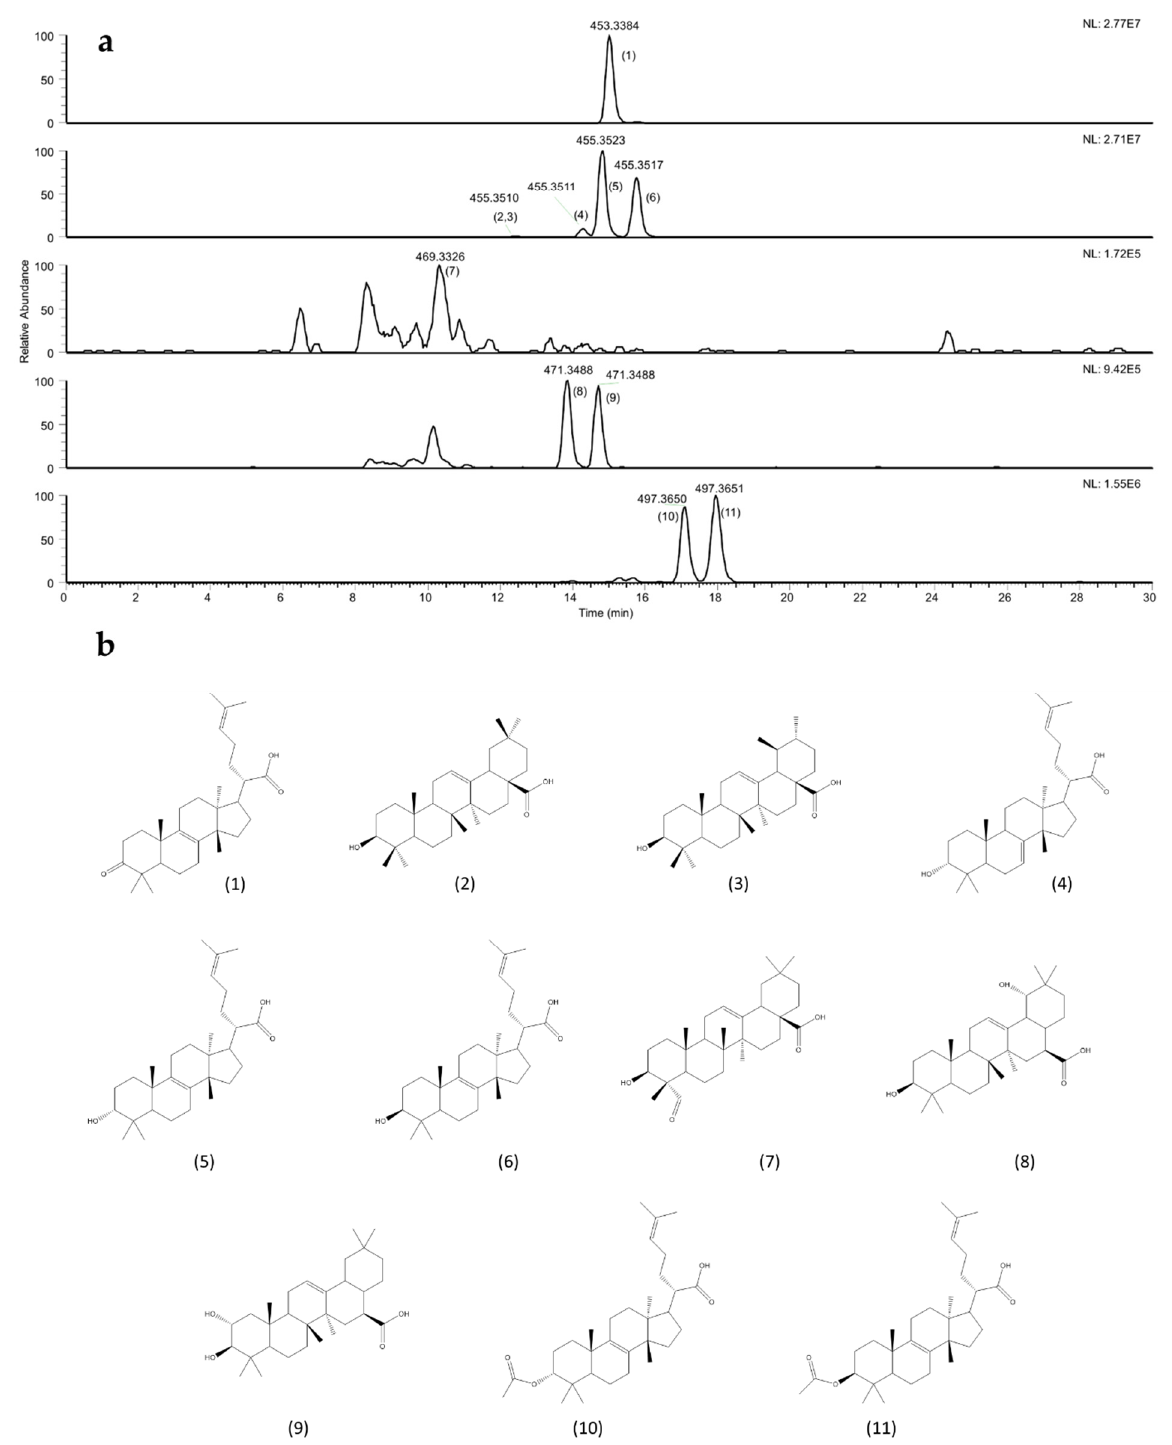
Figure 2. ( a ) Chromatographic separation of acidic triterpenes in ATCE sample; for each peak, m/z accurate value is reported. ( b ) Structure of proposed triterpenes: (1) 3-oxo -tirucalla-8,24-dien-21-oic acid, (2) oleanolic acid (3) ursolic acid (4) 3 α -Hydroxy-tirucalla-7,24-dien-21-oic acid (5) 3 α -Hydroxy-tirucalla-8,24-dien-21-oic acid; (6) 3 β -Hydroxy-tirucalla-8,24-dien-21-oic acid; (7) gypsogenin; (8) siaresinol; (9) maslinic acid; (10) 3 α Acetyl -tirucalla-8,24-dien-21-oic acid; (11) 3 β -Acetyl-tirucalla-8,24-dien-21-oic acid.